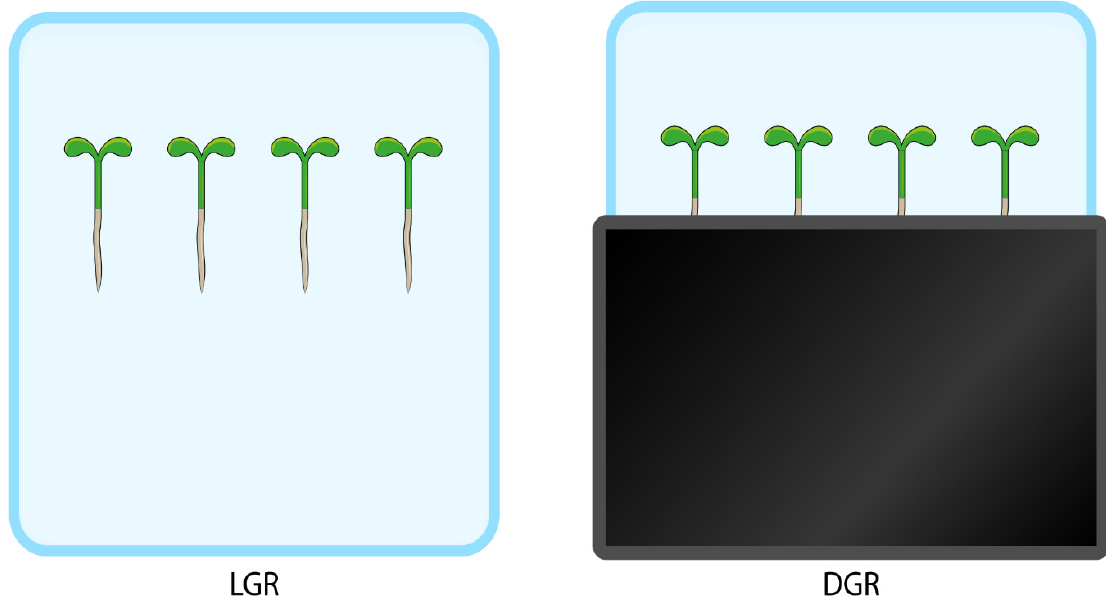
Figure 1. Schematic representation of the principle of light versus dark-grown roots. To shade roots from direct illumination, a cover is used, often made of methacrylate or black cardboard. A video showing how to assemble the so-called D-root system, which is widely used in the D-root community studying Arabidopsis thaliana and was designed by the del Pozo laboratory, is available online https://www.researchgate.net/publication/281436423_Assembling_the_D-root_system (accessed on 23 November 2021) [26] .